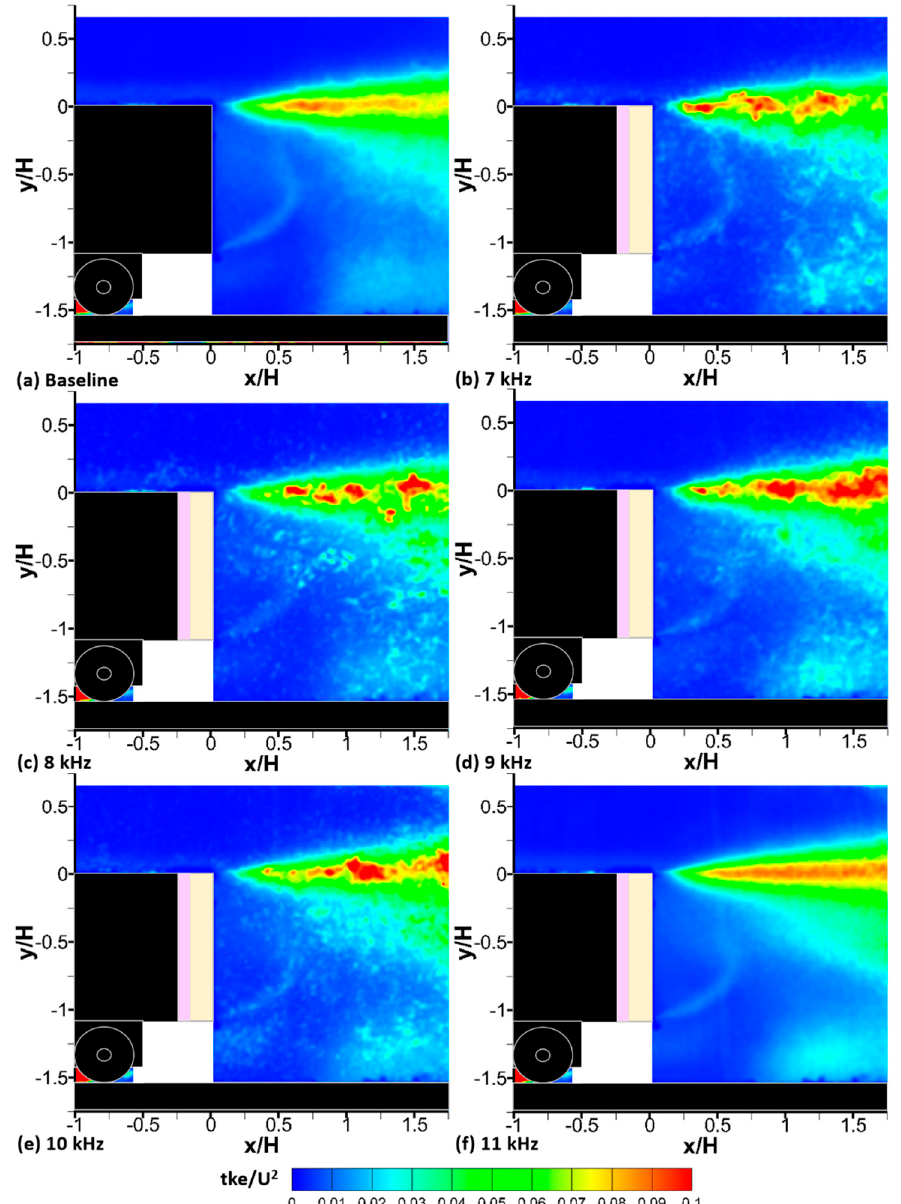
Figure 14. Normalised turbulence kinetic energy downstream of the trailer rear end at various plasma actuation frequencies. ( a ) Baseline, ( b ) 7 kHz, ( c ) 8 kHz, ( d ) 9 kHz, ( e ) 10 kHz, and ( f ) 11 kHz.